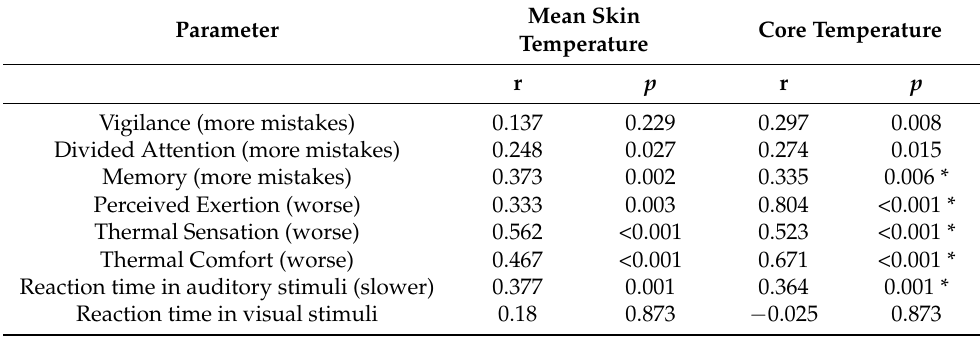
Table A6. Associations between cognitive performance and either the mean skin temperature or core temperatures. * indicates statistically significant association at a Bonferroni adjusted alpha of 0.006.